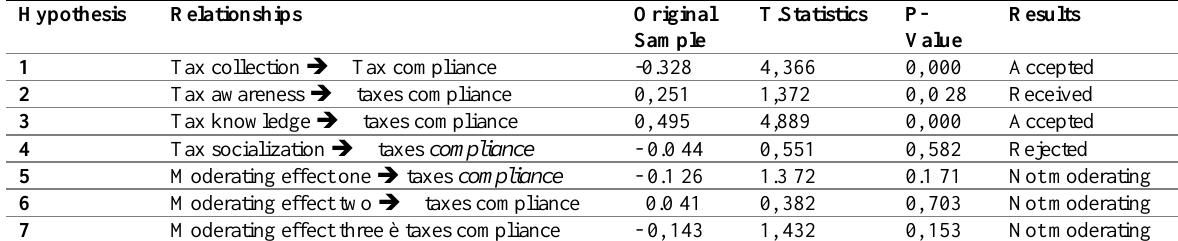
Table 8: Variables, Indicators, Loading Factors, AVEs, and Composite